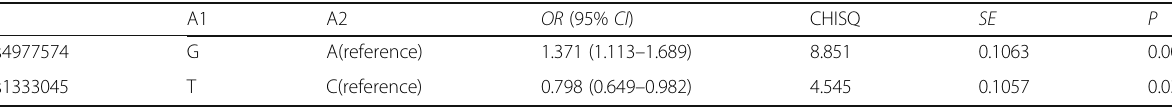
Table 5 The chi-square test of